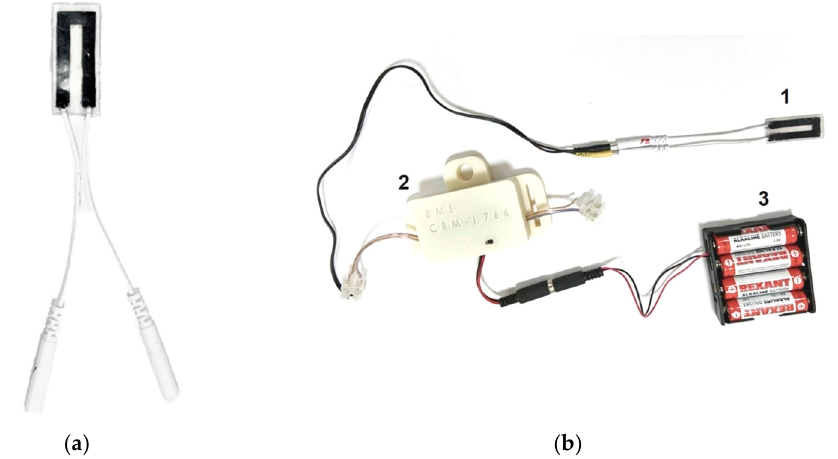
Figure 4. ( a ) Strain-sensitive material; ( b ) strain sensor, where 1—strain sensor, 2—electronic unit, 3—battery pack.